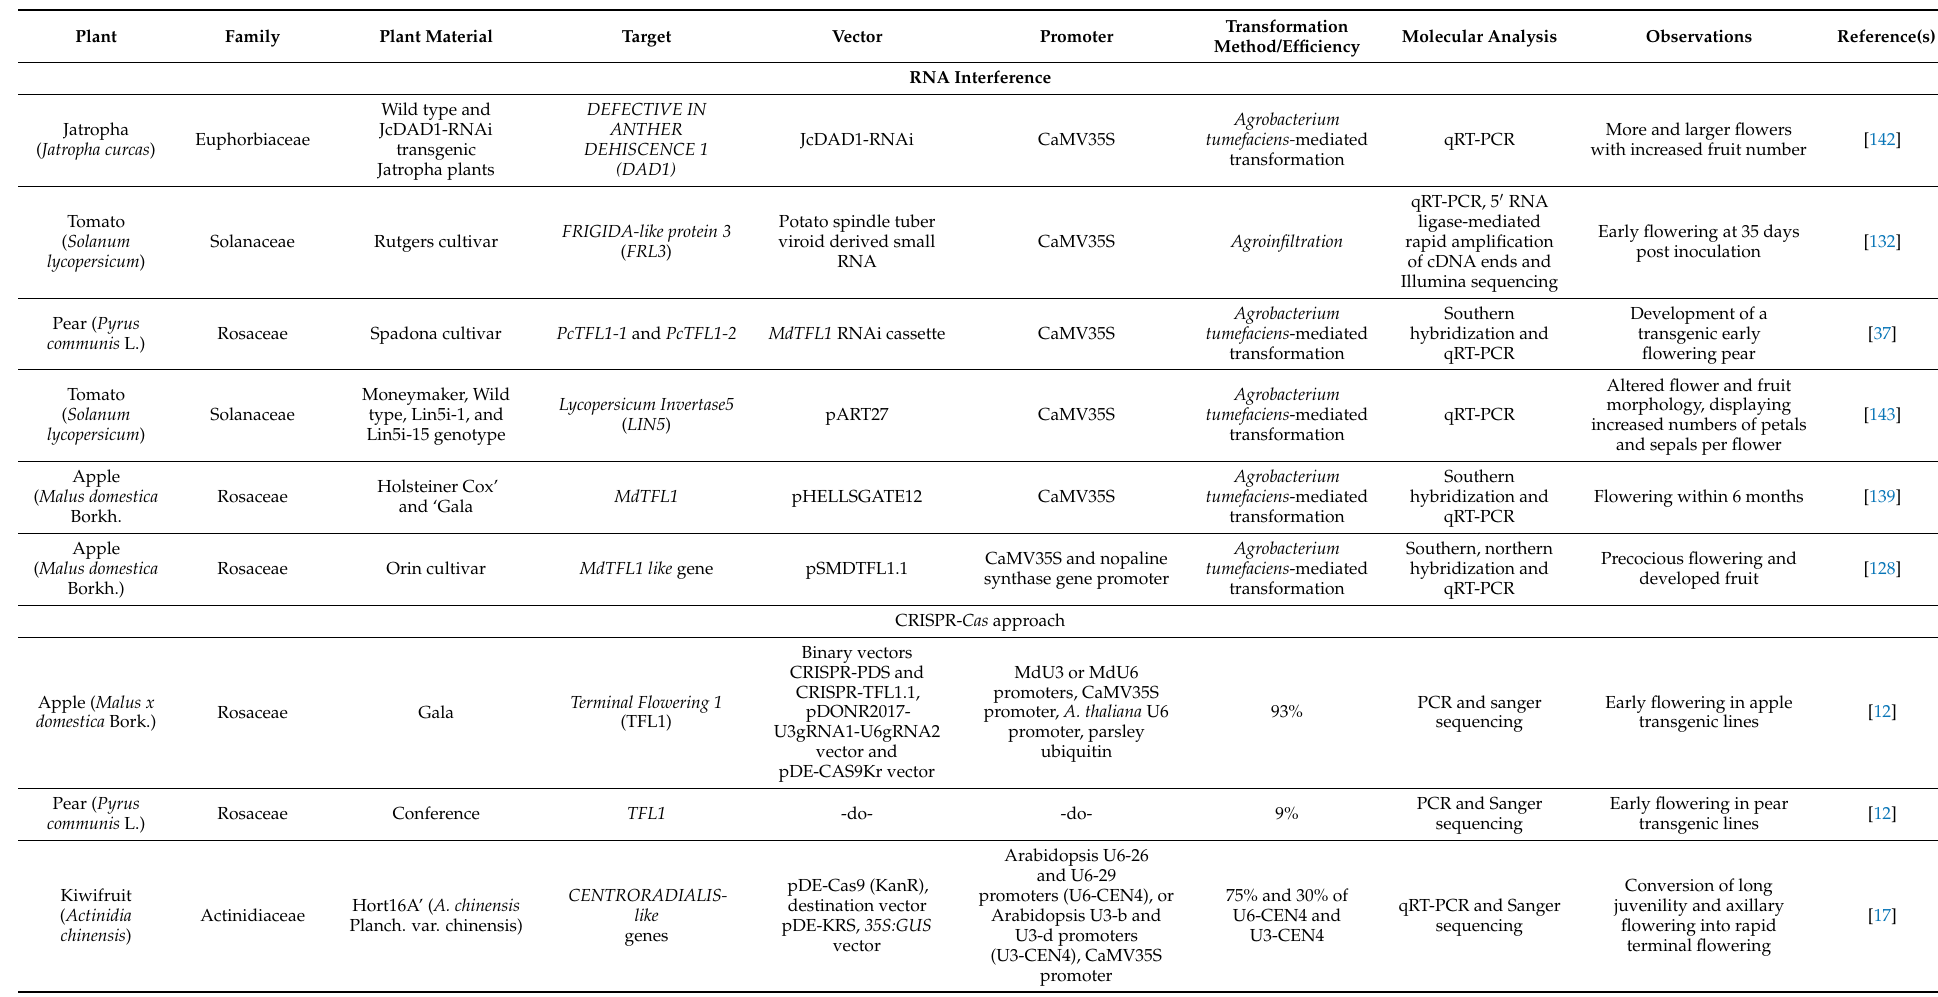
Table 3. Biotechnological approaches (RNA interference, CRISPR- Cas ) for the induction of early flowering in